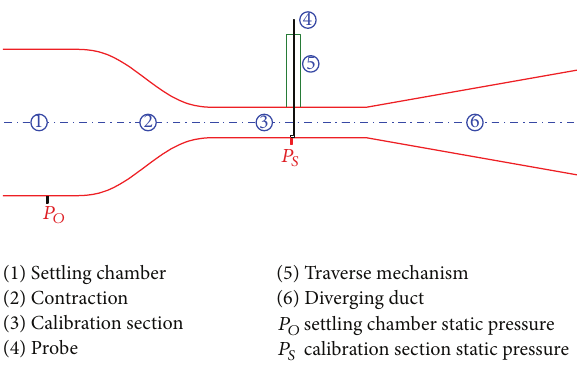
Figure 8: Schematic of calibration tunnel.